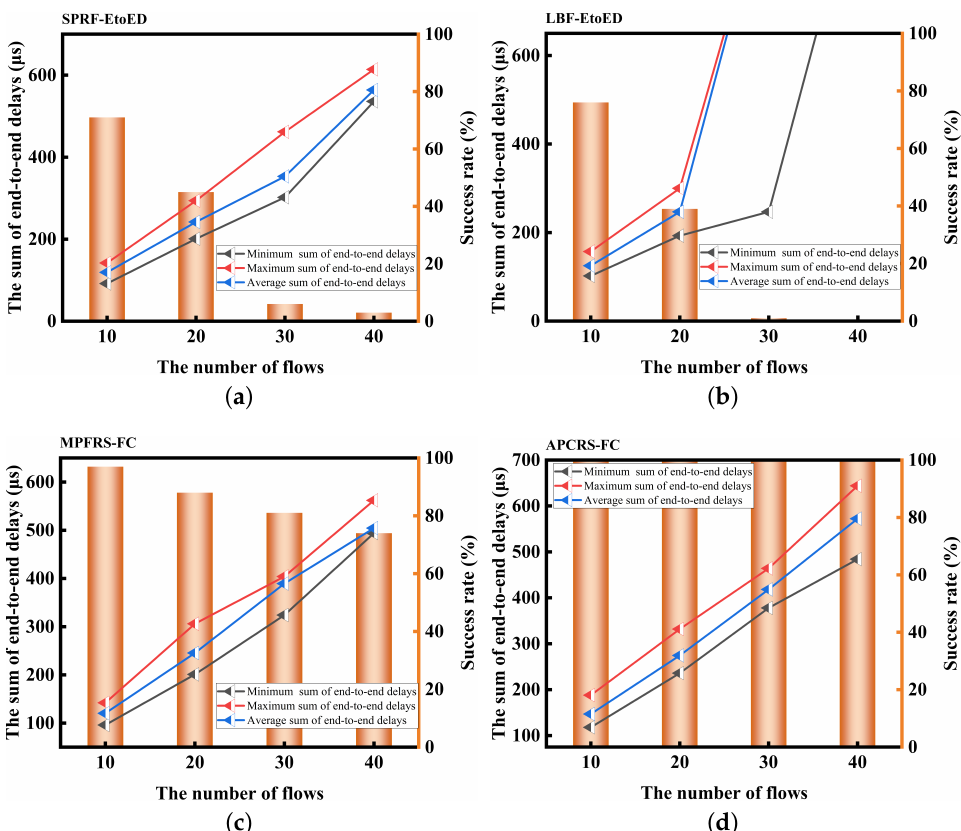
Figure 10. Success rate and the sum of end-to-end delays of the SPRF-EtoED, LBF-EtoED, MPFRS-FC, and APCRS-FC for 100 synthetic test cases with different number of flows chosen from flow group 2, tested in MM network. ( a ) Technique 1: SPRF-EtoED. ( b ) Technique 2: LBF-EtoED. ( c ) Technique 3: MPFRS-FC. ( d ) Technique 4: